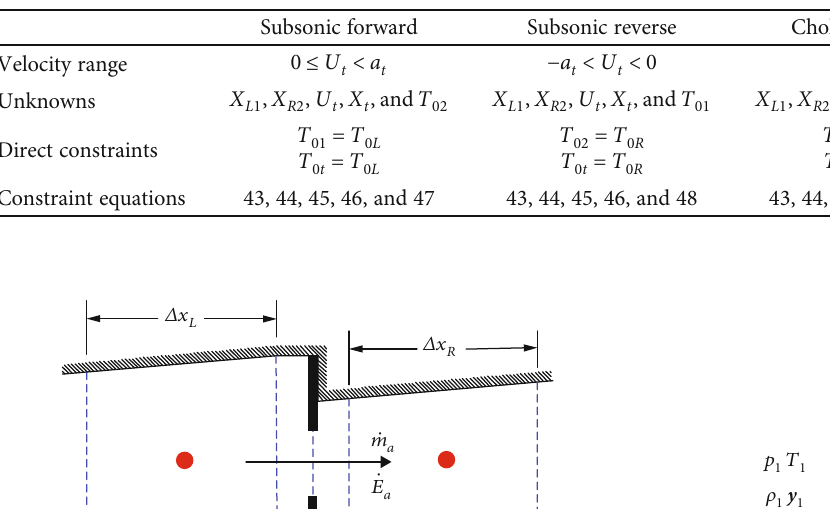
Table 1: Solution summary for adjoined